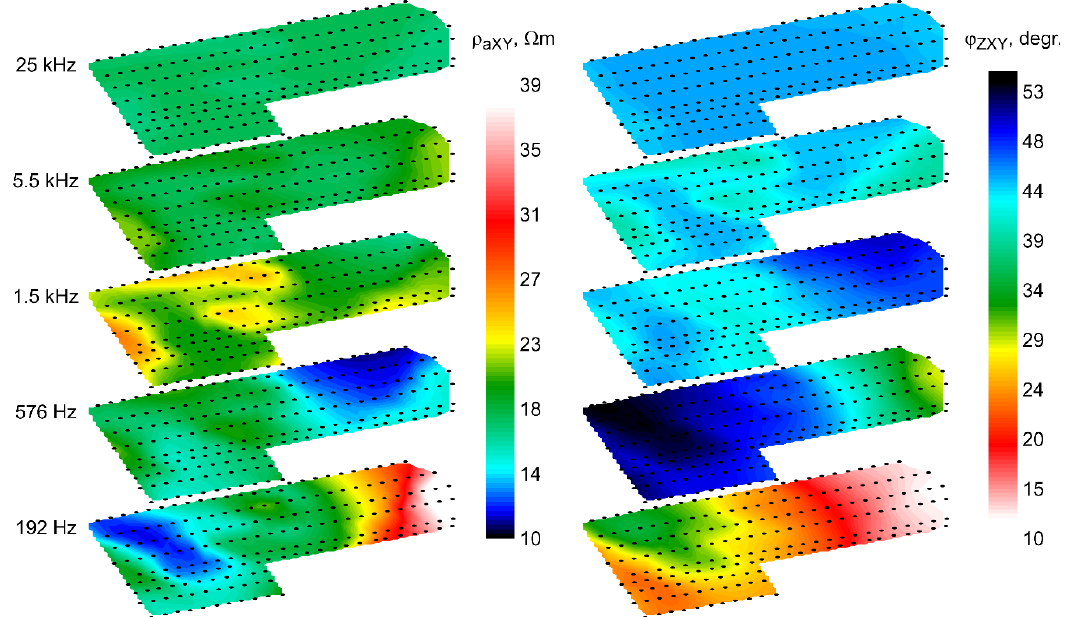
Figure 12. Results of numerical simulation. Maps of XY apparent resistivity and XY impedance component at several frequencies.